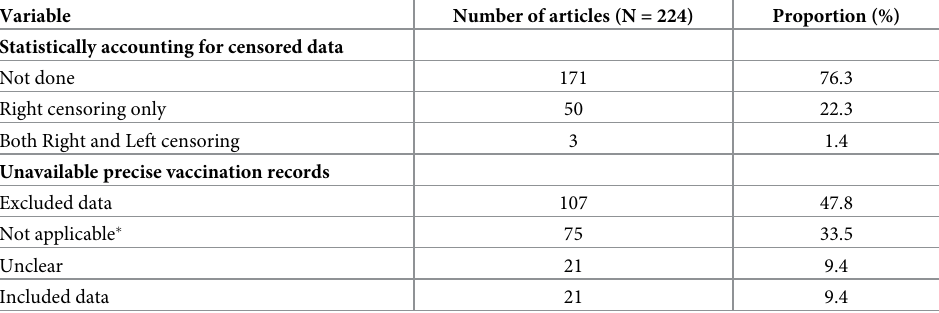
Table 2. Analytic and statistical gaps in the 224 included studies on the timeliness of routine childhood vaccina- tion, 1978–2021.